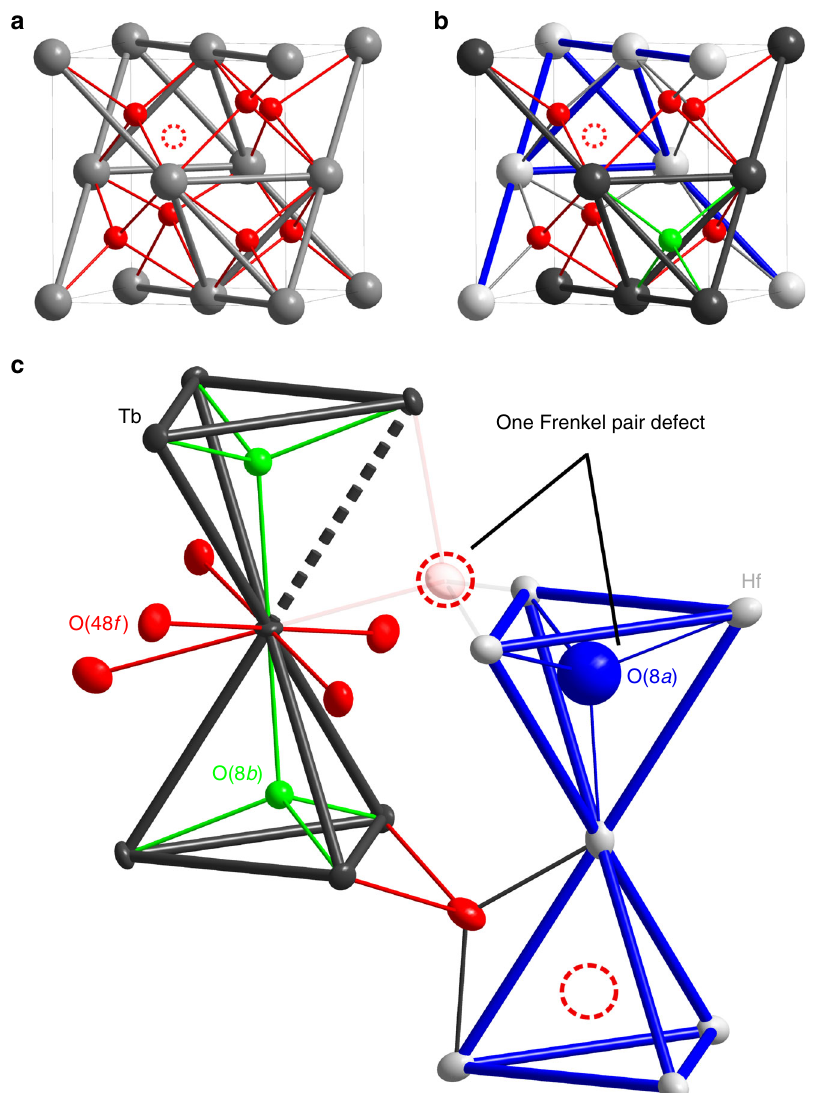
Fig. 1 Crystal chemistry of defective fl uorites, pyrochlores and Tb 2 Hf 2 O 7 . In a , b each unit cell contains one A 2 B 2 O 7 formula unit, but the actual unit cell in b is eight times larger than what is displayed. The A ( black ) and B ( light gray ) cations are fully ordered on distinct crystallographic sites in pyrochlore b and Tb 2 Hf 2 O 7 c structures, while they are disordered on one site (shown in dark gray ) in the defective fl uorite a . Ordered cations imply three distinct Wyckoff positions for anions in the pyrochlore structure Fd -3 m b : 48 f ( red balls ), 8 b ( green balls ), and 8 a that is vacant (center of the B-site tetrahedron, ‘ occupied ’ by a red dashed circle representing a vacancy). Oxygen anions ( red and green balls ) and vacancies ( red dashed circles ) can be disordered ( a ), ordered ( b ), or partially disordered ( c ). On average Tb 2 Hf 2 O 7 c has ~8% of the 48 f positions that are vacant, exactly compensated for stoichiometry by ~50 % of 8 a positions that are occupied ( blue balls ). This average structure corresponds to a random distribution of oxygen Frenkel pair defects. Such a local defect is shown at the top of c , where an empty 48 f position is compensated by a non-vacant neighbor 8 a position, while the situation normally occurring in a perfect pyrochlore is shown at the bottom. Tb 2 Hf 2 O 7 is characterized by a distribution of the two con fi gurations shown respectively on the top and bottom of c . A Frenkel defect has two consequences for the magnetic pyrochlore sublattice of Tb 3+ ions shown in the left part of c ( dark gray ). First, the fi rst- neighbor symmetry around ~50 % of the Tb 3+ cations is broken, because they have seven instead of eight anion ligands. Second, ~8% of the bonds de fi ning the magnetic pyrochlore lattice have one instead of two Tb – O – Tb superexchange pathways, their strength being therefore modi fi ed